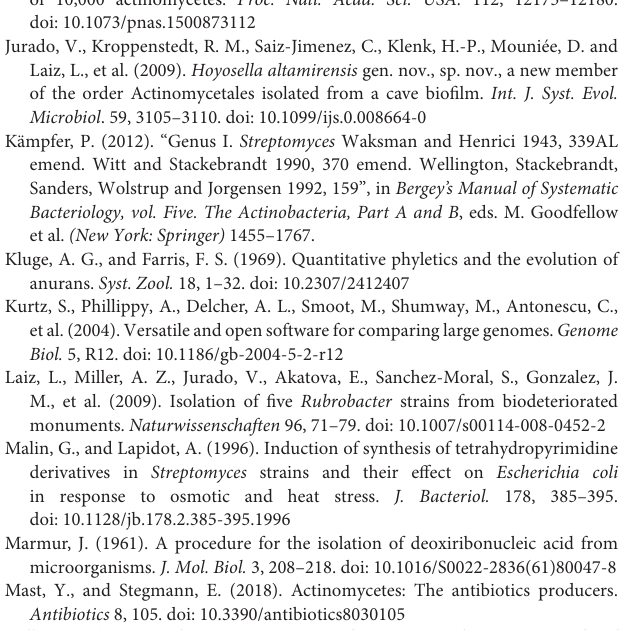
identified closest cluster in the database were omitted. “Similarity” pointed out the % of genes predicted that have been identified in described biosynthetic clusters. The minimum threshold used by anti-SMASH for finding homology fixed a BLAST e-value below 1E-05, a 30% minimal sequence identity, and a coverage of > 25% of the sequence. 1 The query sequence covered only 25% of the closest